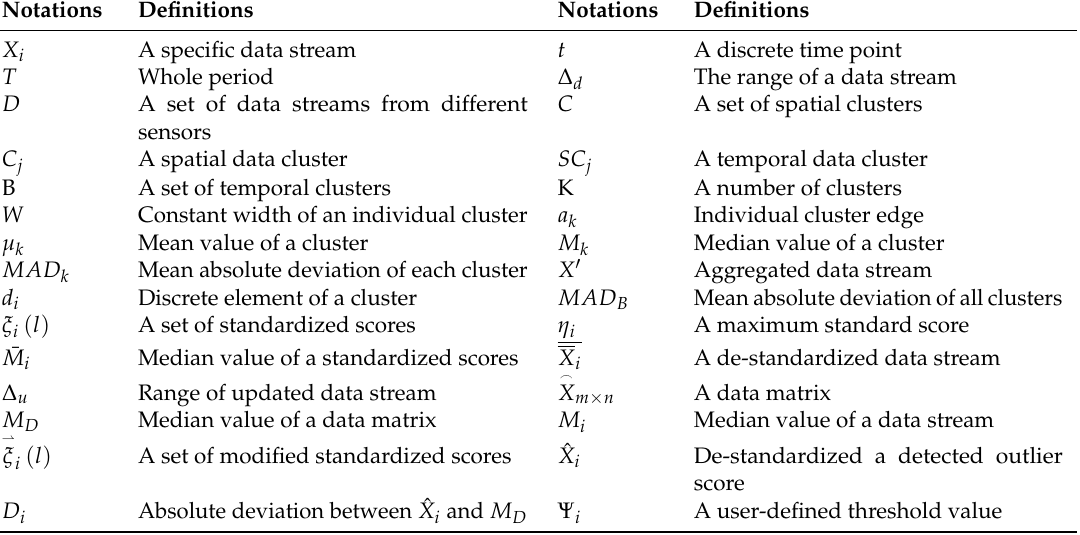
Table 1. A list of the utilized mathematical notations and their